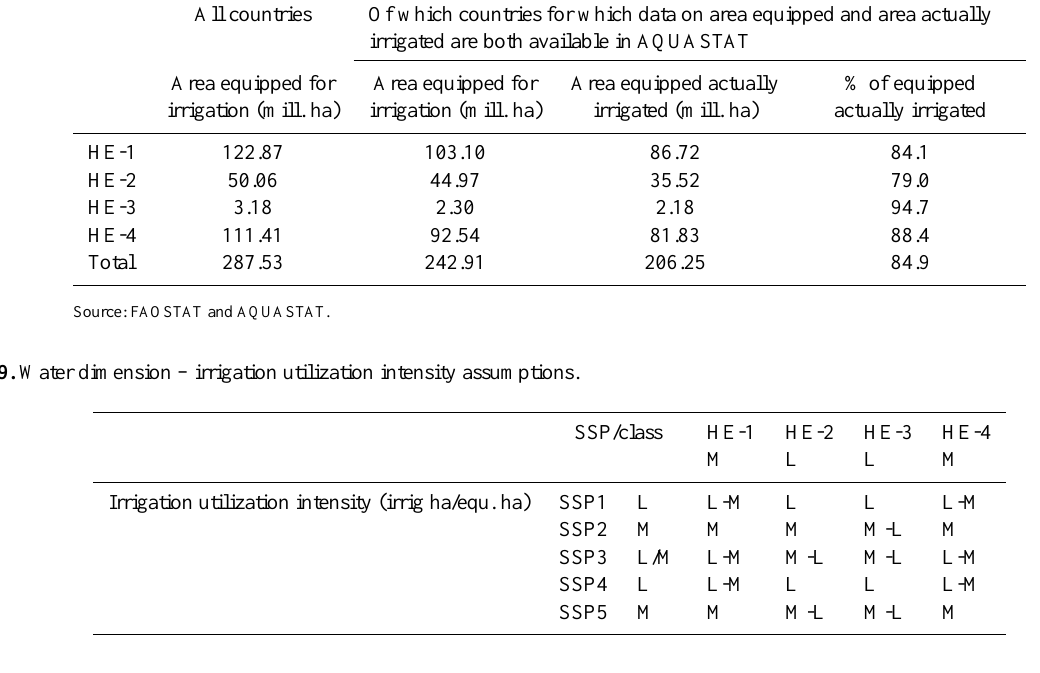
Table A8. Area equipped for irrigation and actually irrigated around the year 2000. All countries Of which countries for which data on area equipped and area actually irrigated are both available in AQUASTAT Area equipped for Area equipped for Area equipped actually % of equipped irrigation (mill. ha) irrigation (mill. ha) irrigated (mill. ha) actually irrigated HE-1 122.87 103.10